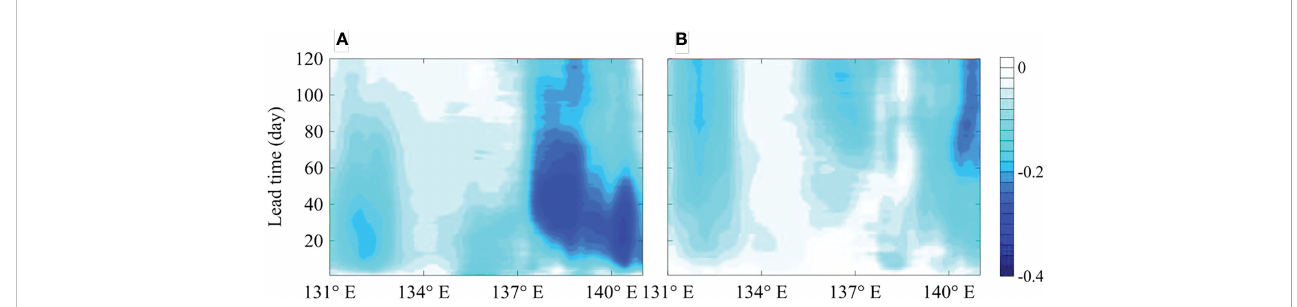
FIGURE 5 (A) Temporal-spatial distributions of difference between the RMSE of the CEOF-LSTM model and that of the EOF-LSTM model in the 1-120 days predictions. Negatives value means that the RMSE of the CEOF-LSTM model is smaller than that of the EOF-LSTM model. (B) Same as (A) , except for the difference between the RMSE of CEOF-BEMD-LSTM model and that of the CEOF-LSTM model. Negatives value means that the RMSE of the CEOF- BEMD-LSTM model is smaller than that of the CEOF-LSTM